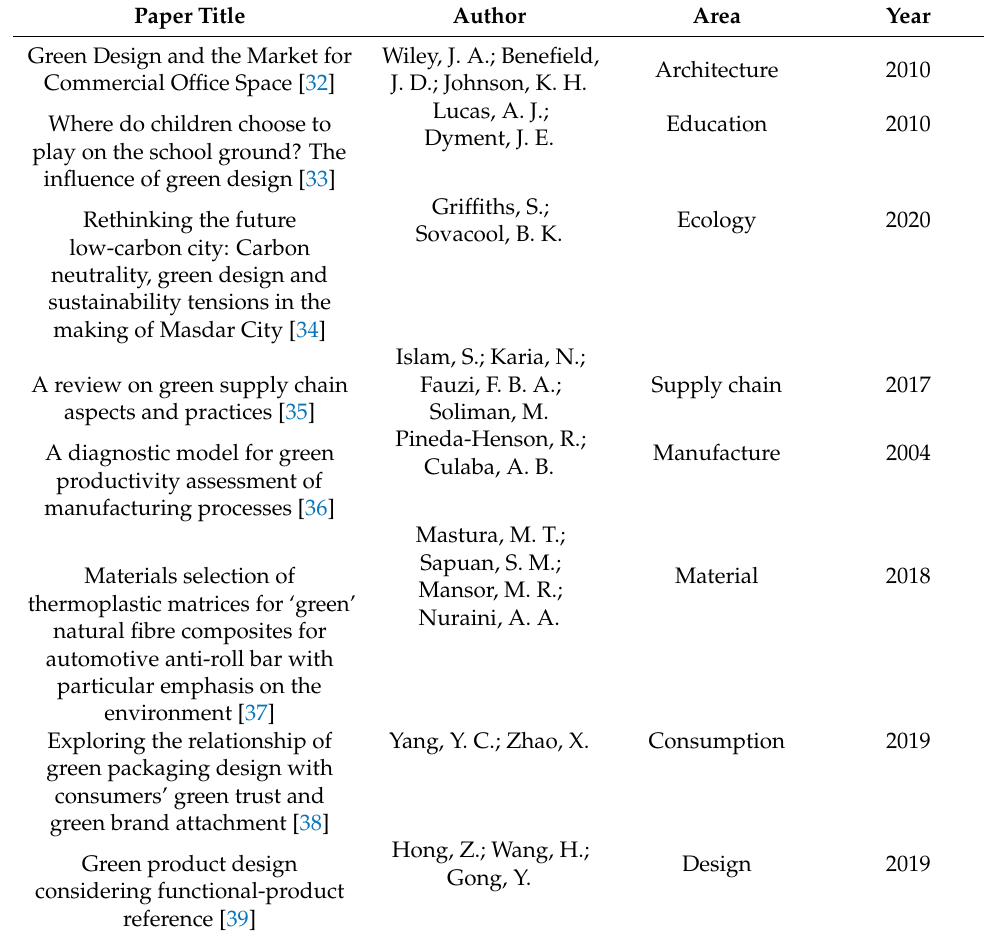
Table 1. Discussion and application cases of green design concepts in different